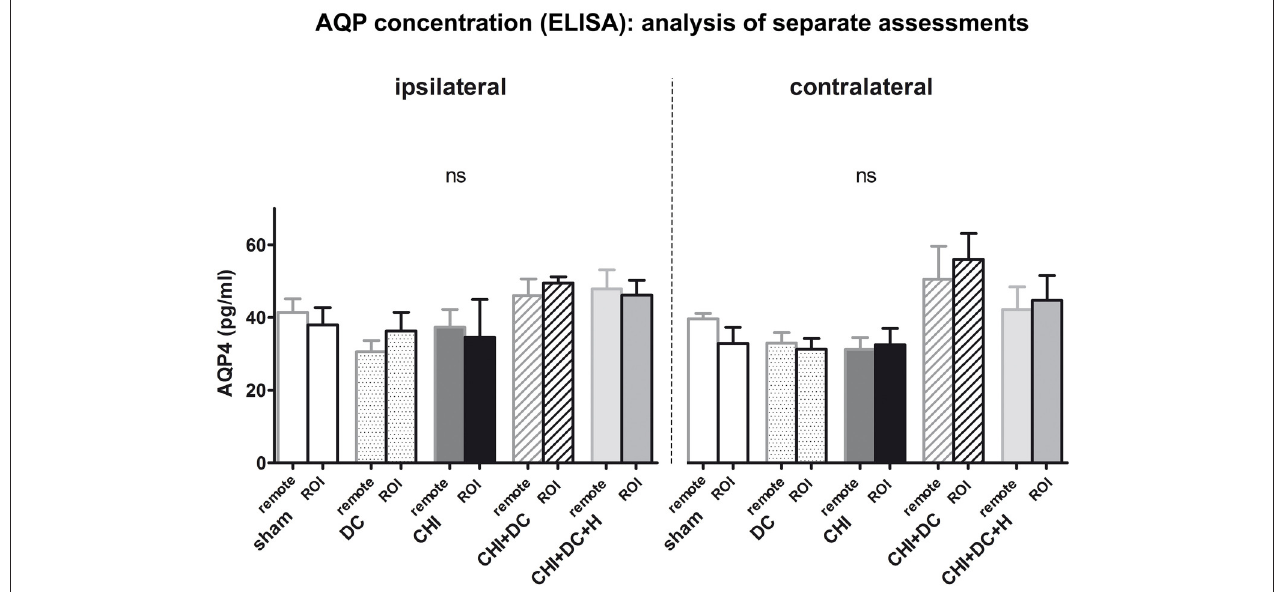
FIGURE 3 | Histogram showing concentration of AQP4 24h after trauma/sham injury according to ELISA assessment. The graph represents separate analysis of data i.e., the values are discriminated as to the localization of the sample (ROI vs. remote parts of the brain and ipsi- vs. contralateral hemisphere). Both the response to injury (AQP4 level change) and the differences between single treatment groups seem to be more prominent in contralateral hemisphere (containing more viable tissue), although according to the ANOVA analysis, no statistically significant differences can be registered (ns, p > 0.05 for comparison of groups, matched in distance or laterality in regard to injury epicenter). CHI, closed head injury; DC, decompressive craniectomy; H, hypothermia; ROI, region of